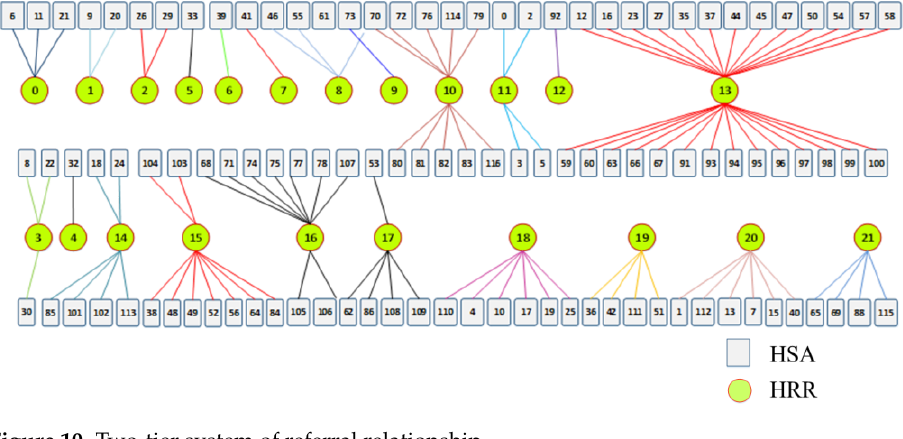
Figure 9. Spatial distribution map of two-tier referral system.